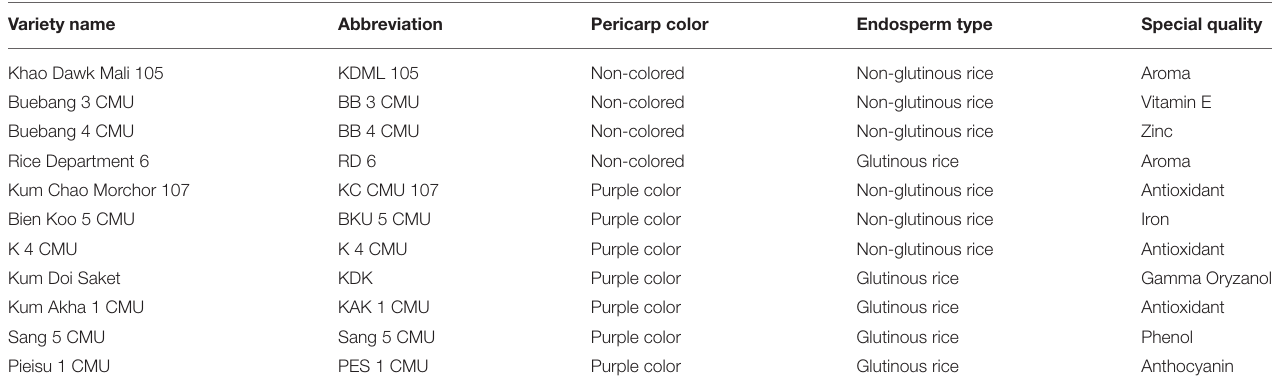
TABLE 1 | Description of rice varieties with special grain quality used in the